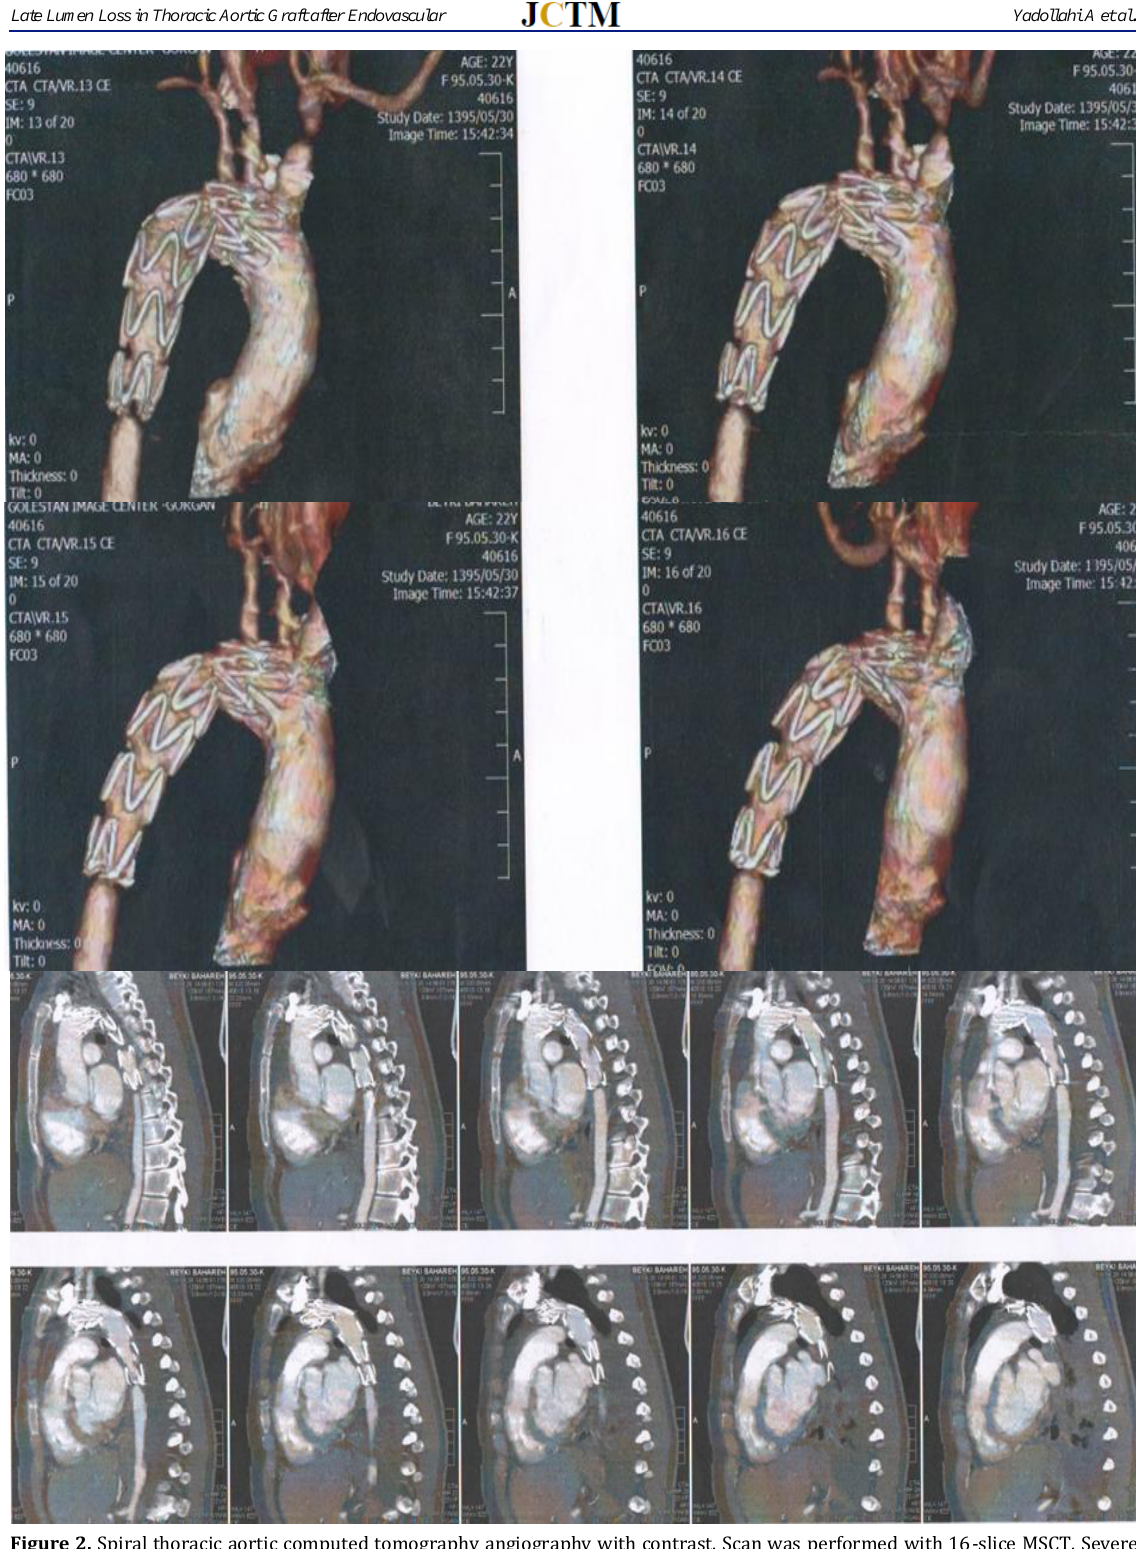
Figure 2. Spiral thoracic aortic computed tomography angiography with contrast. Scan was performed with 16-slice MSCT. Severe stenosis (>90%) of the thoracic aortic lumen at the distal end of the stent has